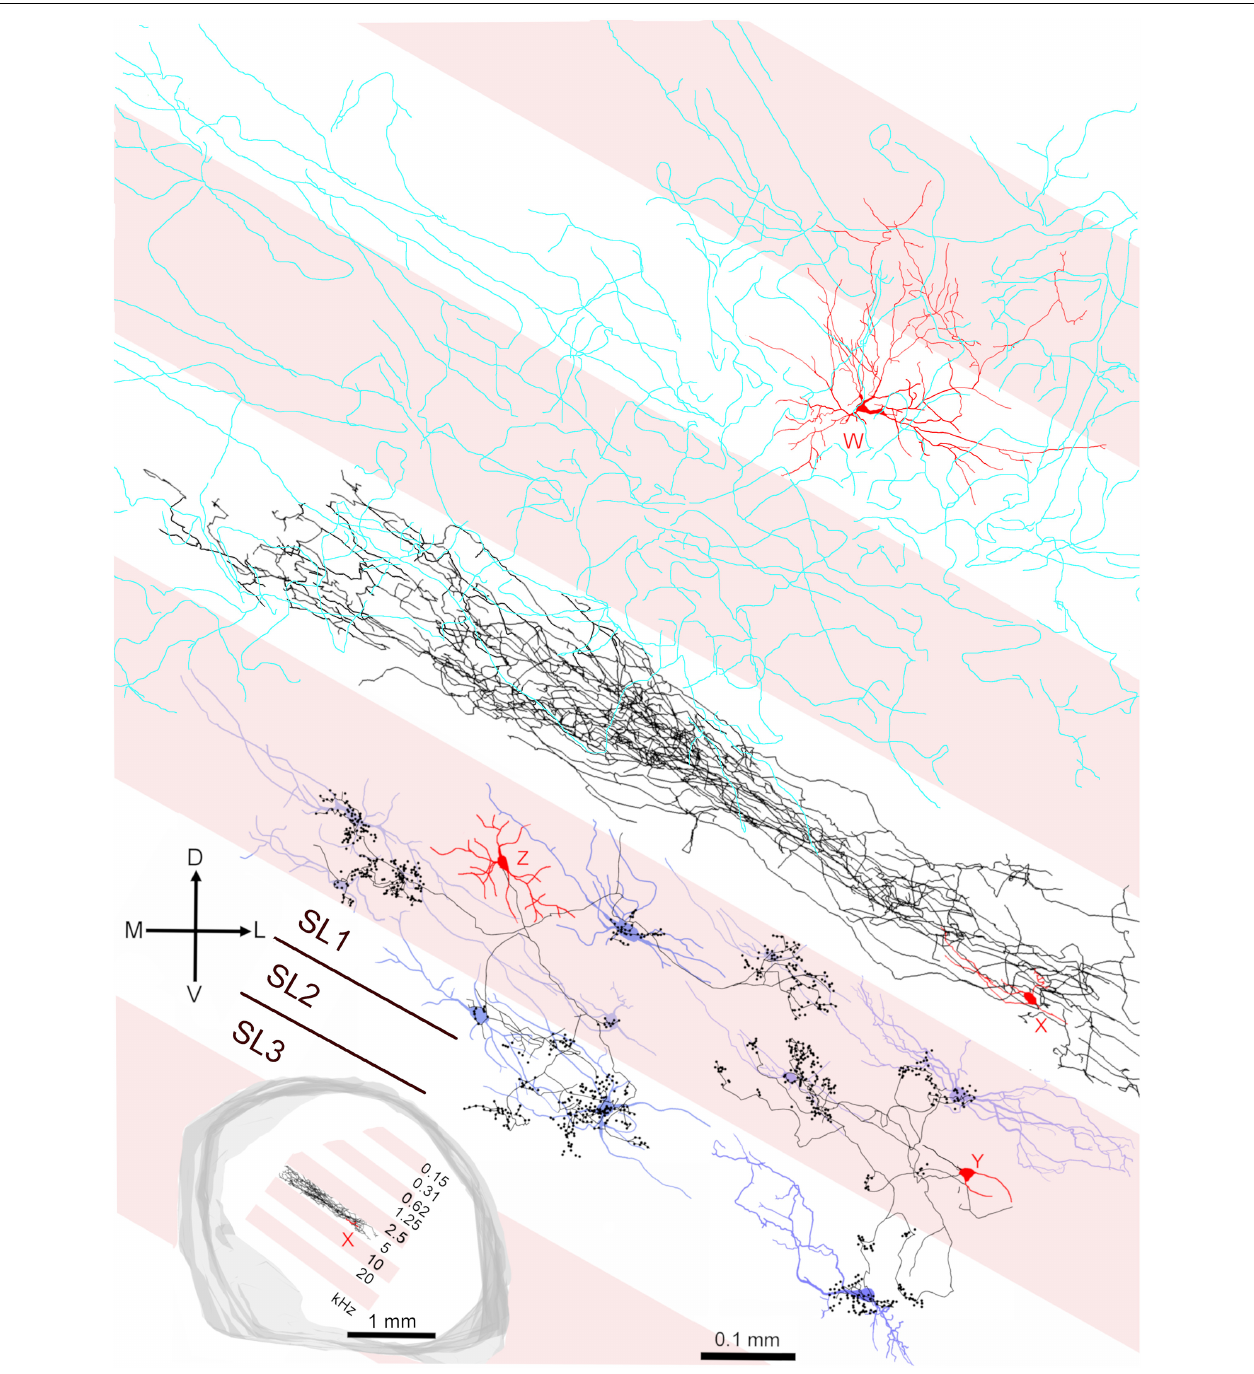
FIGURE 11 | Summary diagram illustrating the relationship of the three main types of cell in the central IC in relation to the fibrodendritic laminae. The alternating pink/white bands represent physiological laminae with an octave spacing as indicated by the inset on the lower left. The cell W (418L) is a large spherical stellate cell (CF 1.25 kHz) with an onset response and an extensive axonal plexus (colored cyan) that crosses several laminae (shown in Figure 8D ). The cell X (411L) is a small, flat elongated disk cell (CF 4.9 kHz) with a sustained response and an axonal plexus that is restricted to a single lamina. The cells Y (464R; CF 6.65 kHz) and Z (350R; CF 12.3 kHz) are medium flat cells with chopper responses that have basket-like axonal endings in their own and at least one adjacent lamina. Cells Y and Z show the potential interactions between the axonal clusters of basket cells and laminar disk cells. Each of the disk cells (blue soma and dendrites) was reconstructed in our previous study (Wallace et al., 2012) but have been arbitrarily placed in a lamina irrespective of their actual CF. Each idealized fibrodendritic lamina has a width of 200 µ m. Cell Y should be located in the white lamina along with cell X as they have similar CFs. However, it was moved into the adjacent pink lamina for the sake of clarity. The white band centered on 20 kHz has two straight lines in it showing that each lamina may be divided into three sublaminae (SL1-3).